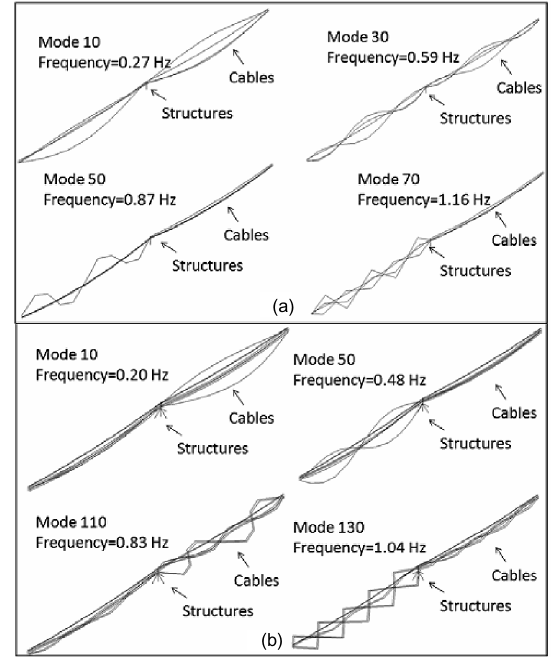
Fig. 2. Representative cable-leading modes of the coupled system: (a) concrete pole; (b) steel pole.